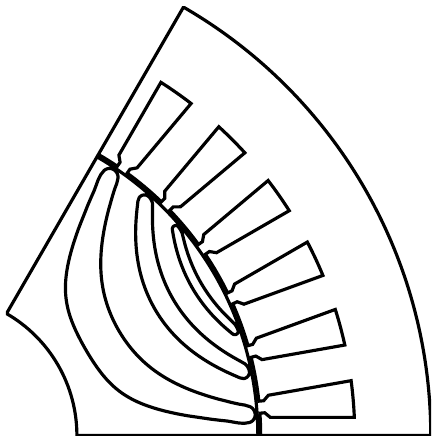
Figure 2. Stator and rotor of the benchmark machine.